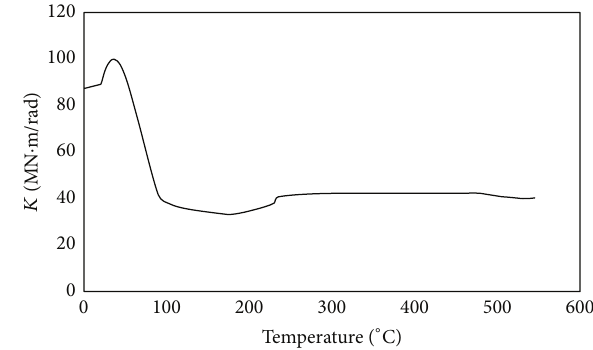
Figure 21: The temperature graph: the rotation with bolted T joint.